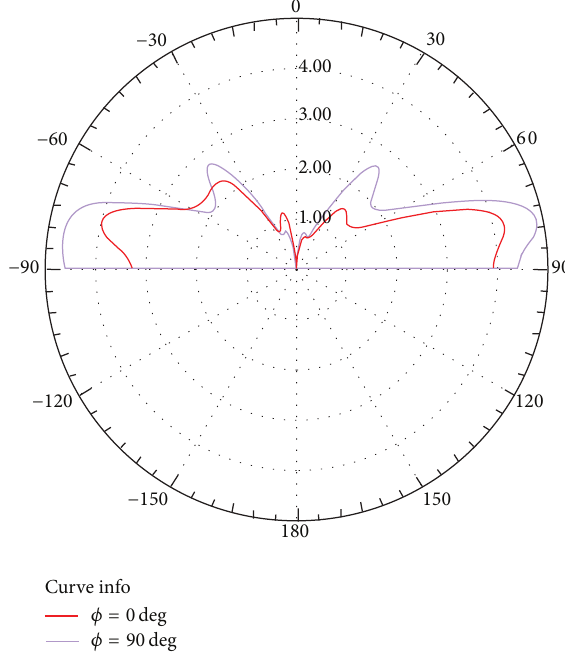
Figure 14: Directivity of the CRA for the second iteration at 6.55